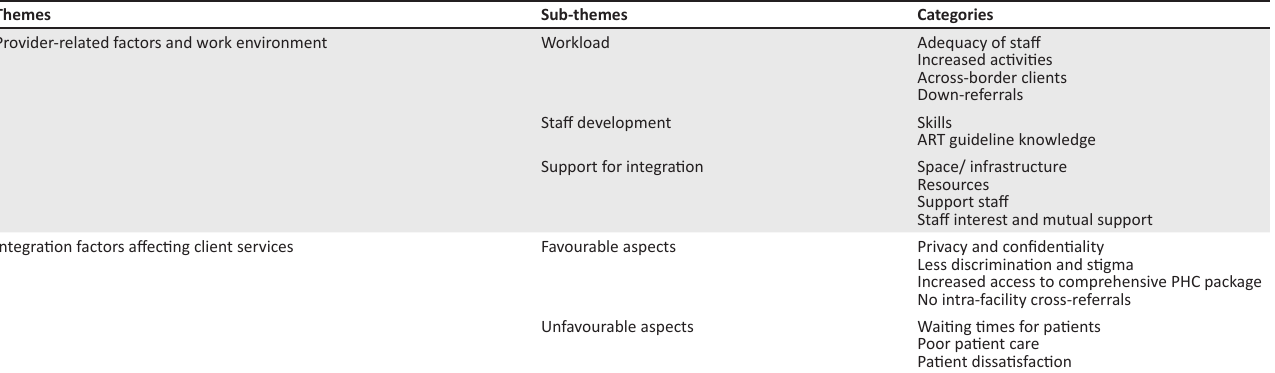
TABLE 1: Clinician perceptions of factors affecting integration and quality of